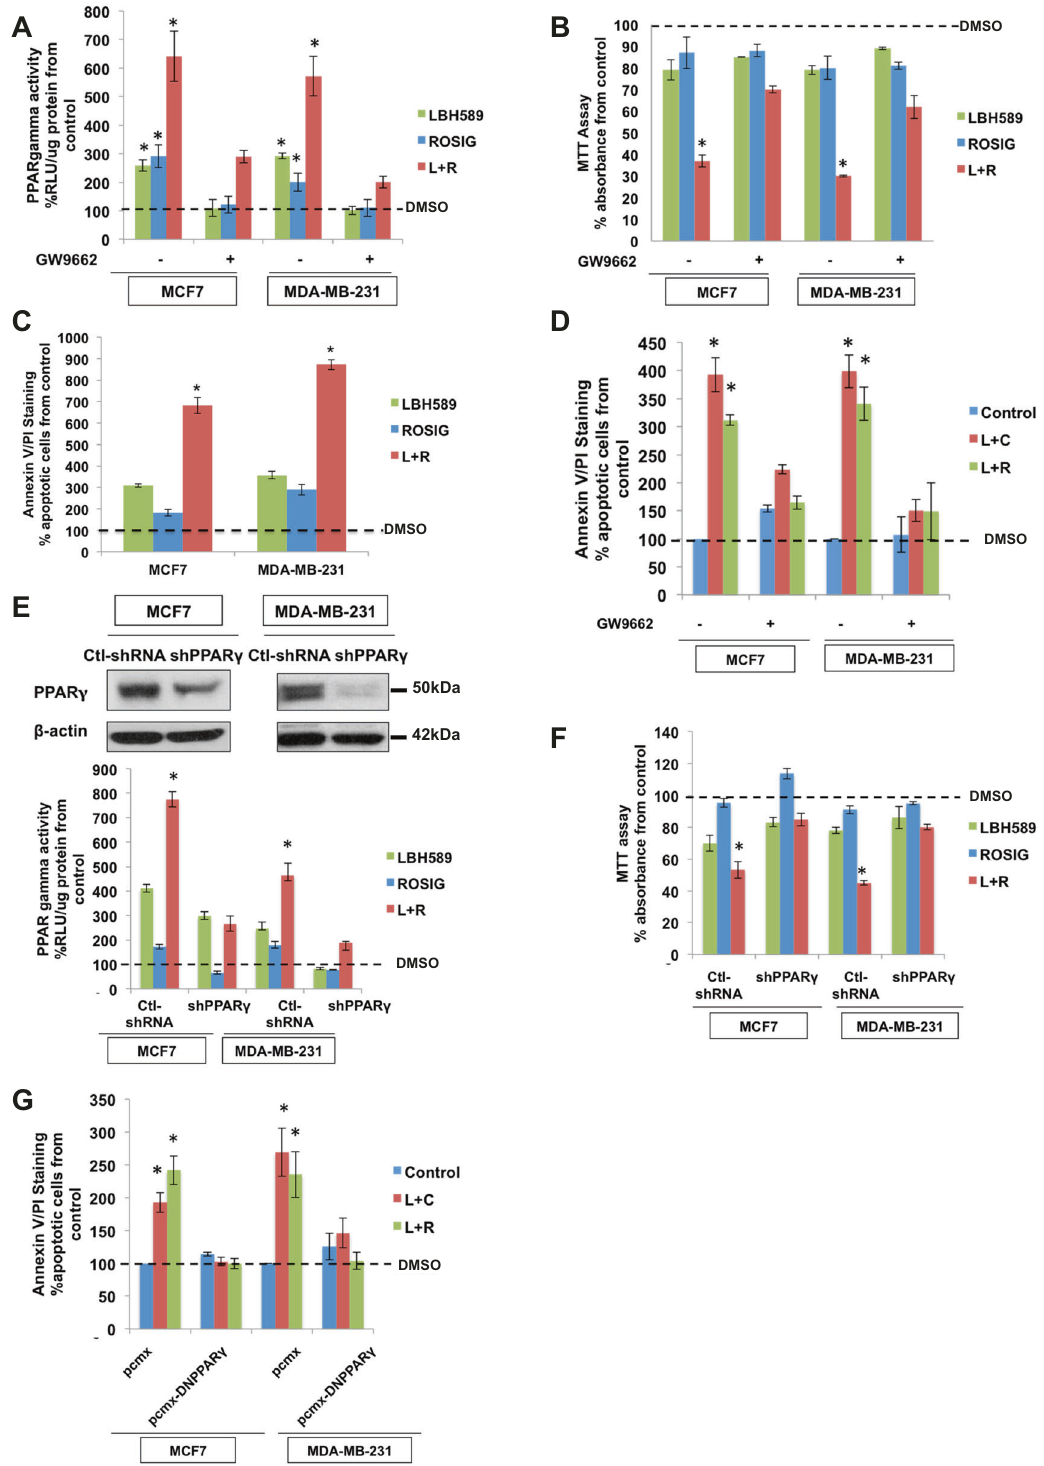
therapy restrained angiogenesis to a considerably greater extent than the individual monotherapies in capillary tube formation assays and CAM experiments. A summary of the functional effects induced by the combination treatment of LBH589 and PPAR γ activation is illustrated in Fig. 6F. To ensure the veracity of our conclusions, we replicated all experiments involving the combination therapy by